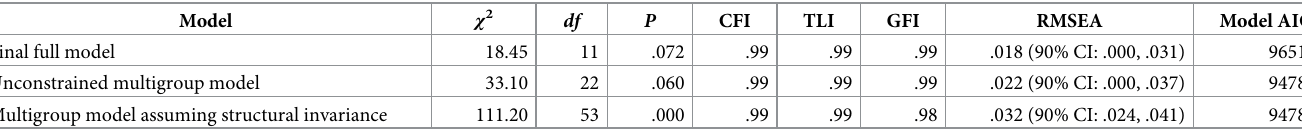
Table 3. Fit statistics for the structural equation models.